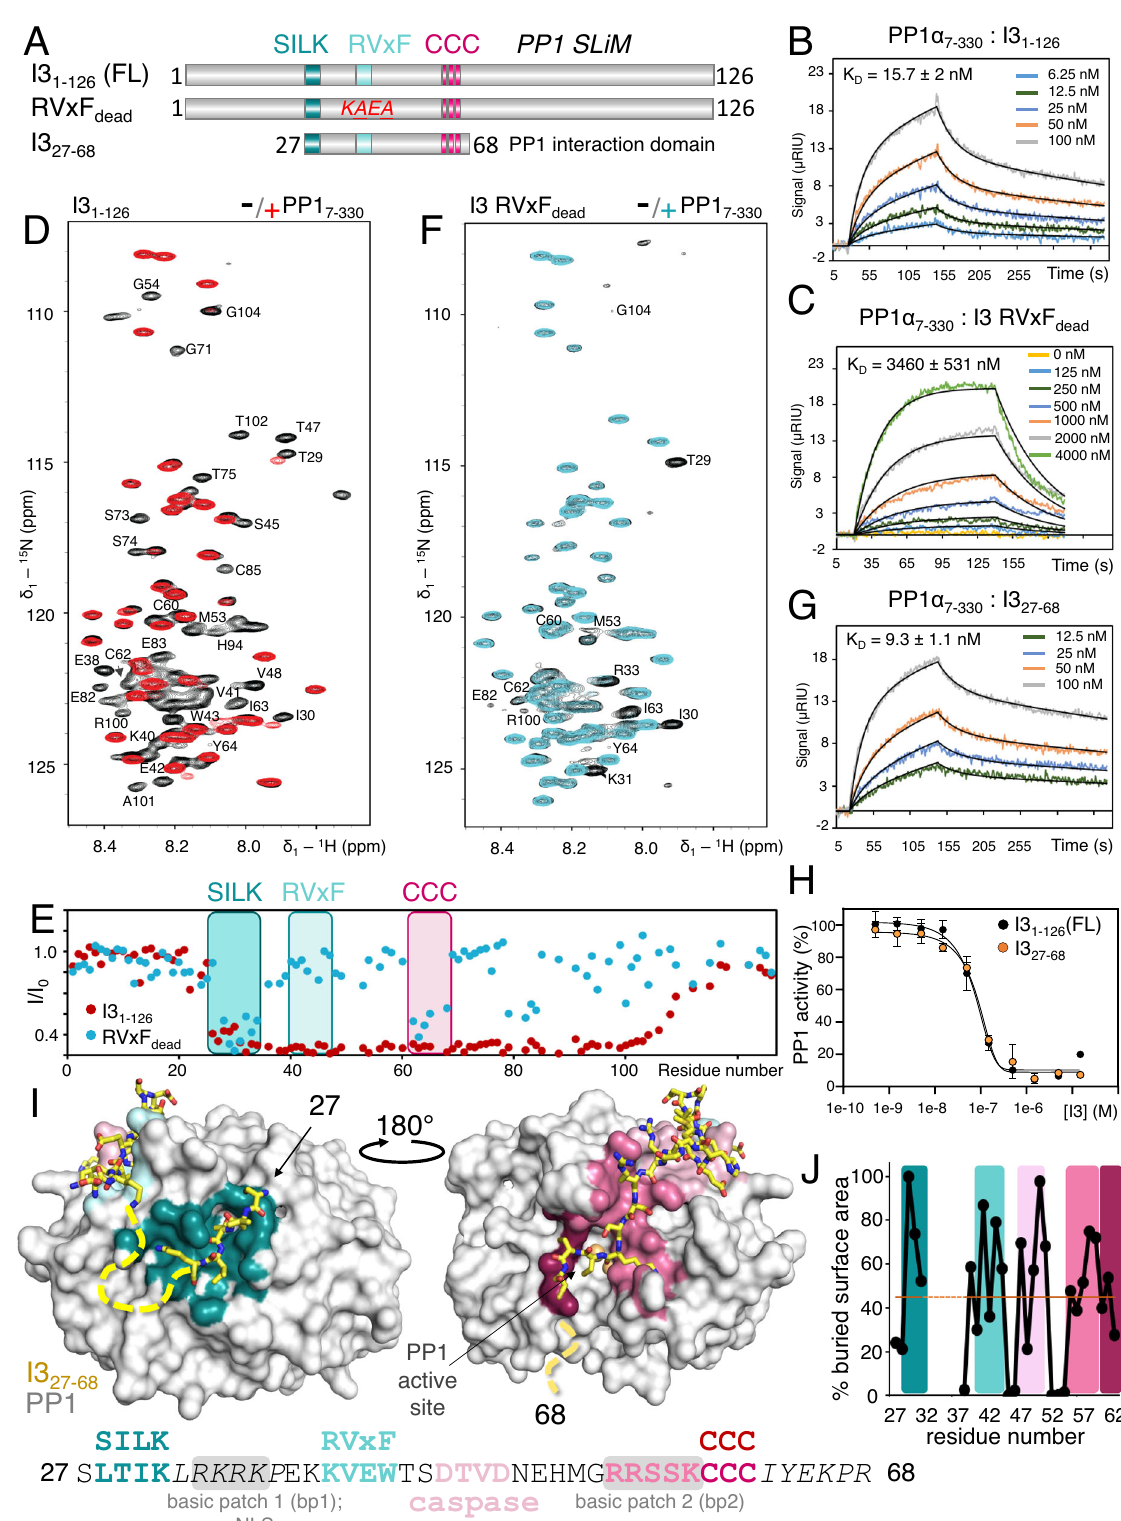
Fig. 1 | I3 interactionwithPP1.A Domain structureof I3. PP1-speci fi c SLiMs (SILK [teal], RVxF [turquoise] and CCC [dark pink]) are indicated. Additional constructs relevant to this fi gure are also shown. B SPR sensorgram for I3 1-126 and PP1 α 7-330 . C SPR sensorgram for I3 1-126 RVxF dead and PP1 α 7-330 . D 2D [ 1 H, 15 N] HSQC spectrum of 15 N-labeled I3 1-126 alone (black) and in complex with PP1 α 7-330 (red). E Peak intensity loss vs I3 protein sequence plot; SLIMs indicated with the same colors shown in A . F 2D [ 1 H, 15 N] HSQC spectrum of 15 N-labeled I3 1-126 RVxF dead alone (black)andincomplexwithPP1 α 7-330 (cyan). G SPRsensorgramfortheminimalPP1